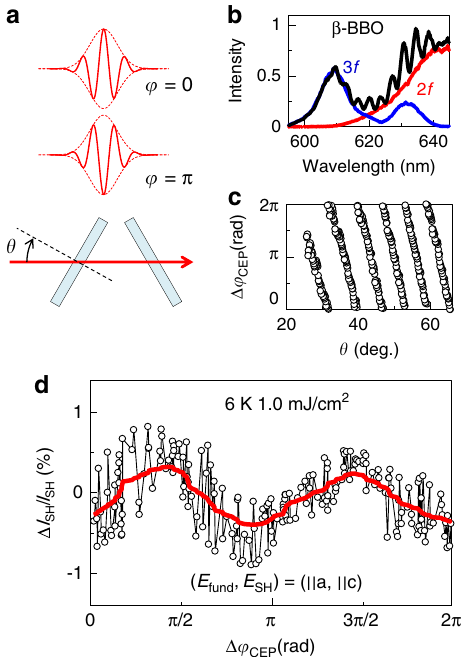
Fig. 3 CEP control of SHG. a Schematic illustrations of the CEP ( φ CEP = 0, π ) and the pair of BK-7 plates (thickness 1 mm) for changing the relative CEP Δ φ CEP ( θ : incident angle of light). b Interference spectrum between 2 f and 3 f of the fundamental light. The 2 f and 3 f are generated using β -BBO. c Δ φ as a function of θ (which is obtained by the 2 f – 3 f interferometer). d Intensity change of the SHG ( Δ I SH / I SH ) as a function of Δ φ . The red curve is obtained by averaging the data (guide to the